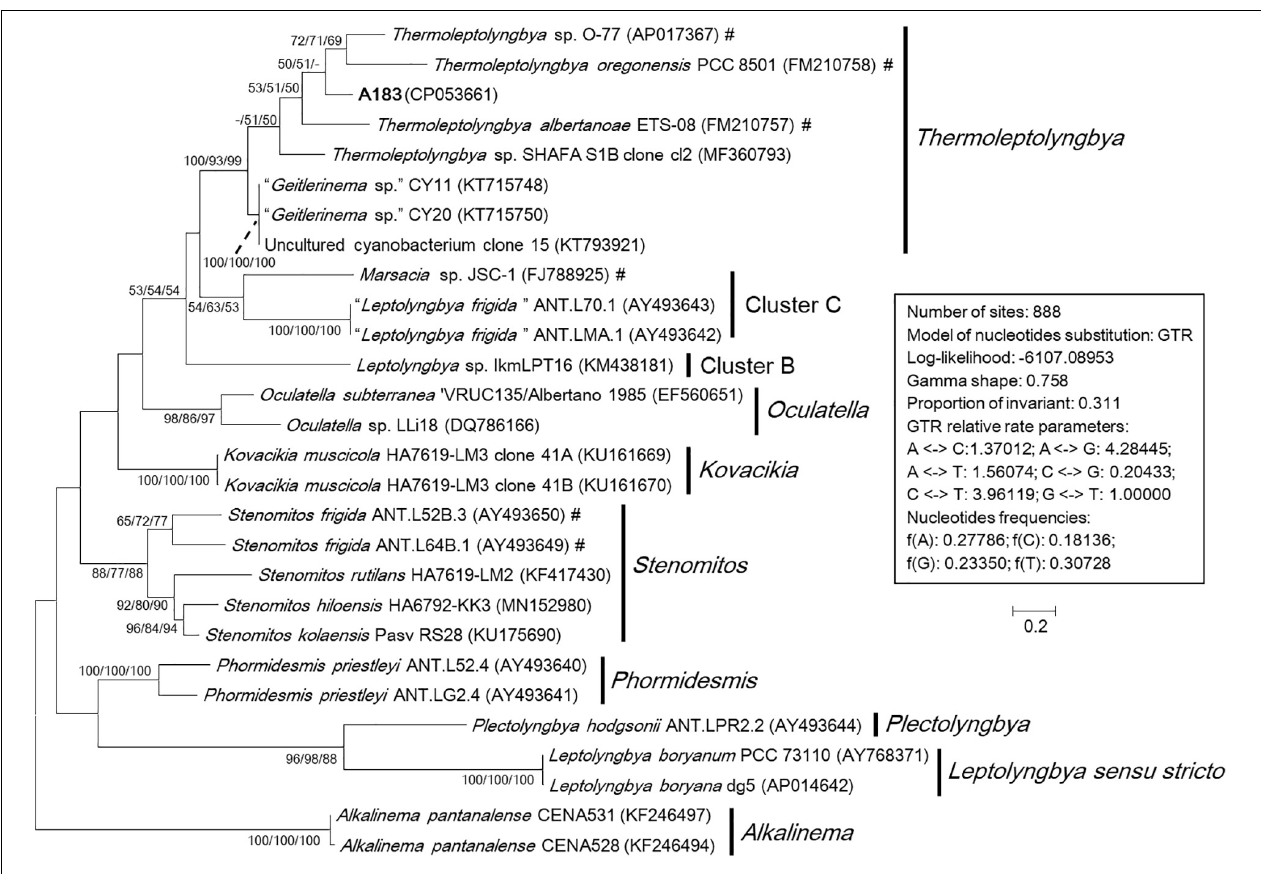
FIGURE 4 | Maximum-likelihood phylogenetic tree of 16S-23S ITS sequences. The numbers at nodes refers to the support values of ML, MP, and NJ analysis, respectively. Only bootstrap values > 50% (1000 non-parametric replications) are indicated at nodes. Genera or cluster are indicated by vertical bars. Scale bar = 20% substitutions per site. Strains in “quotation marks” have uncertain genus names. Strains marked with # have been recently reclassified or proposed to be